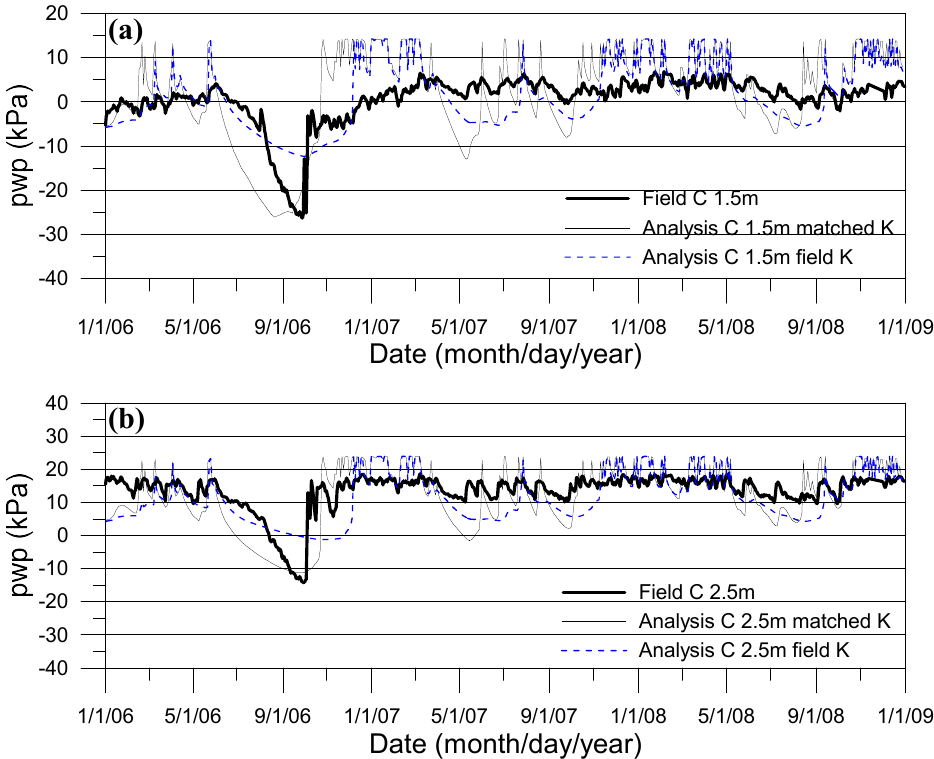
Figure 11. Field measured and calculated pore water pressure at ( a ) 1.5 m depth and ( b ) 2.5 m depth at section C. The near-surface soil suctions were recorded by standard water-filled tensiometers at different depths (0.3, 0.6 and 0.9 m from the surface at locations A and C). Figure 12a,b